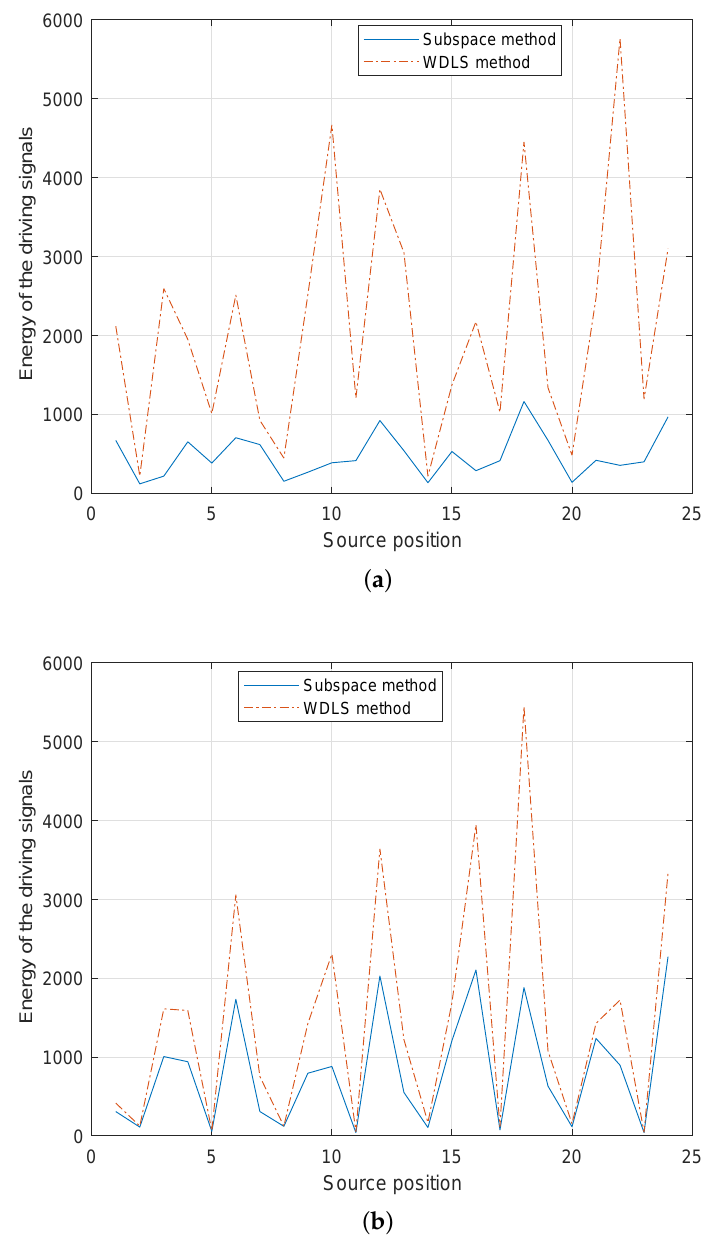
Figure 9. Energy of the driving signals generated by one primary source moving around the sphere using different methods: ( a ) case 3; ( b ) case